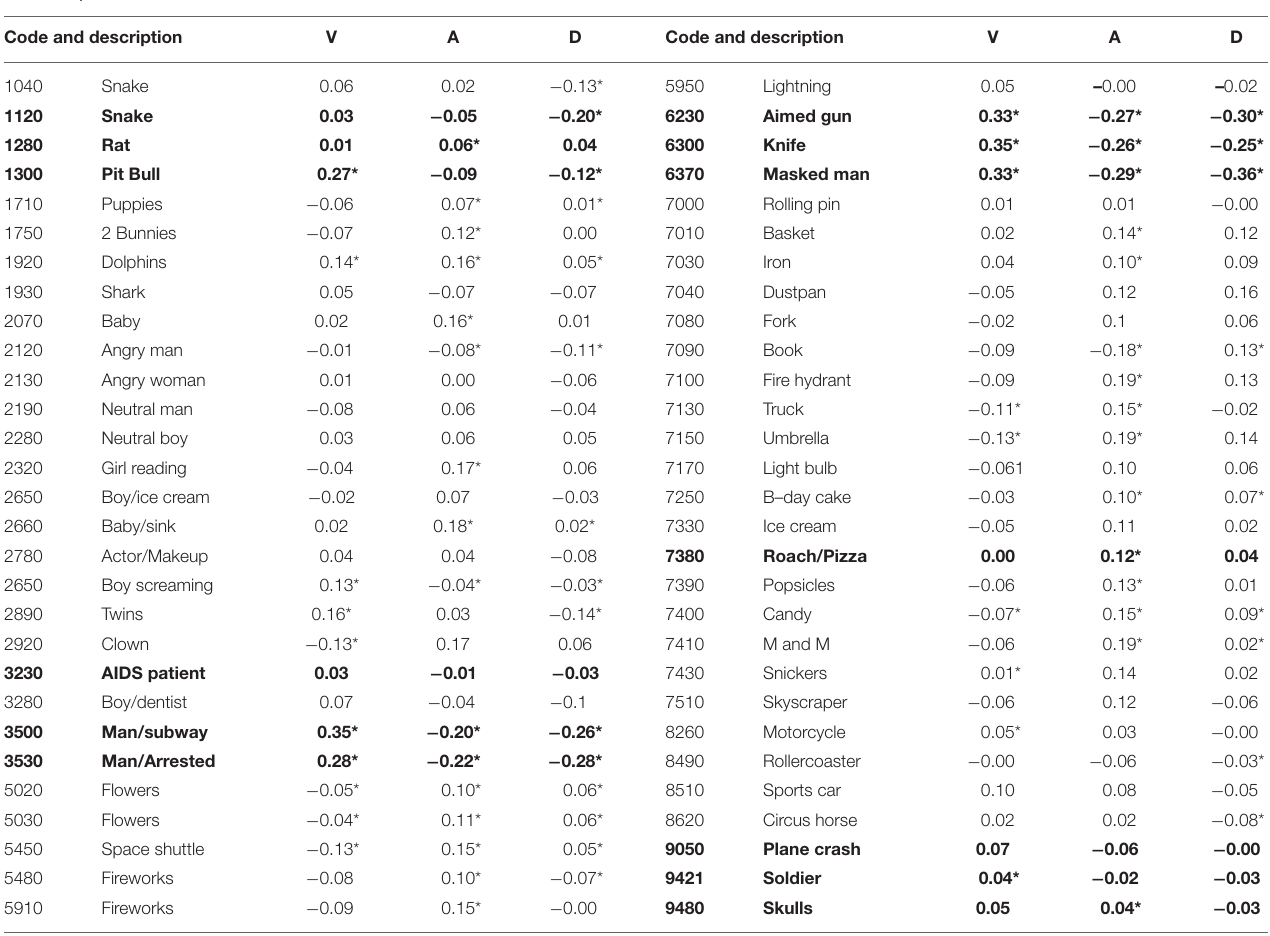
TABLE 4 | Structure of function 1 for each